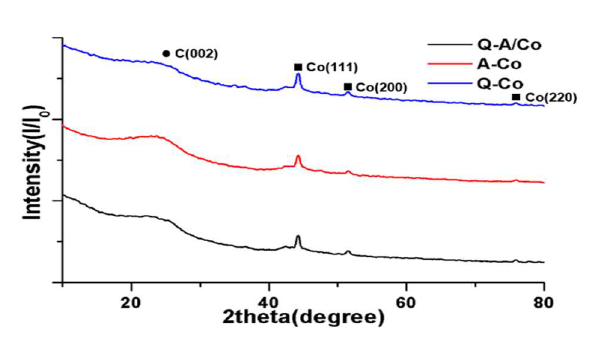
Figure 5. XRD patterns obtained for metal cobalt-N doped carbon.